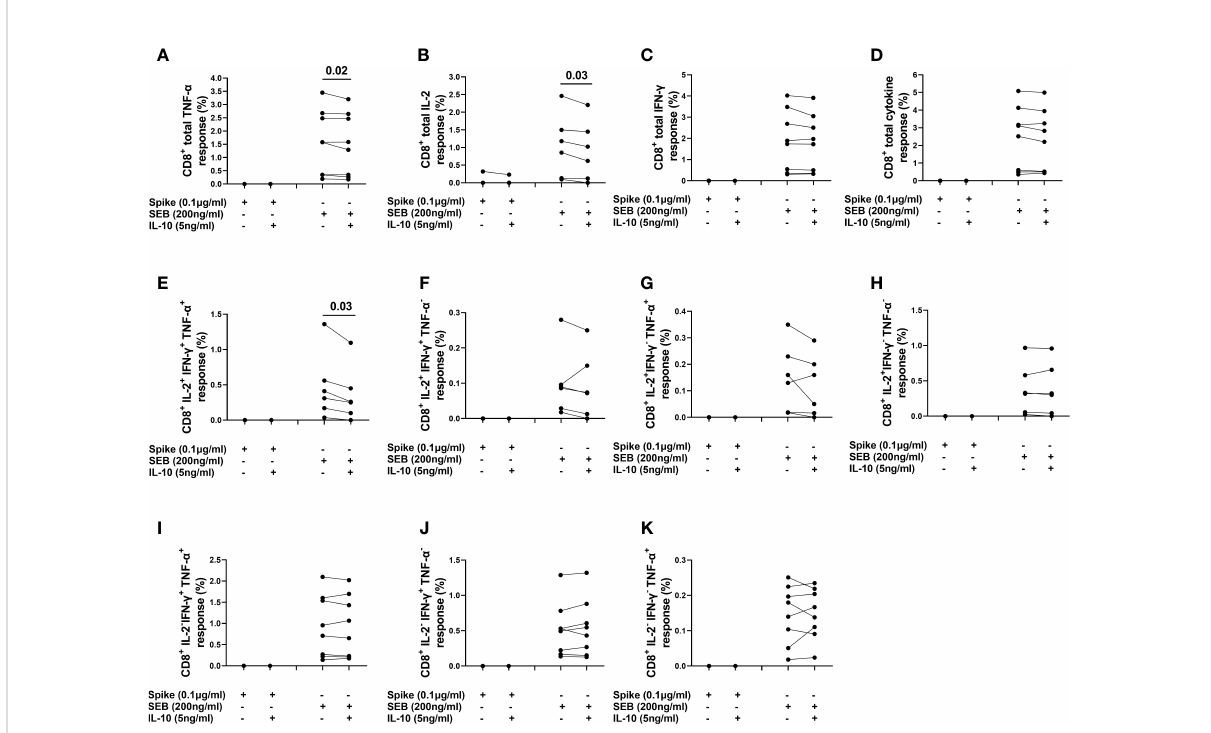
FIGURE 8 Evaluation of the effect of IL-10 on CD8 + T-cells populations in NO COVID-19-Vaccinated Controls of study population “ B ” , by fl ow cytometry (n=8). (A) Percentage of CD8 + TNF- a + cells; (B) percentage of CD8 + IL-2 + cells; (C) percentage of CD8 + IFN- g + cells; (D) percentage of total cytokine response of CD8 + cells; (E) percentage of CD8 + IL-2 + IFN- g + TNF- a + subset; (F) percentage of CD8 + IL-2 + IFN- g + TNF- a - subset; (G) percentage of CD8 + IL-2 + IFN- g - TNF- a + subset; (H) percentage of CD8 + IL-2 + IFN- g - TNF- a - subset; (I) percentage of CD8 + IL-2 + IFN- g + TNF- a - subset CD8 + IL-2 - IFN- g + TNF- a + subset; (J) percentage of CD8 + IL-2 - IFN- g + TNF- a - subset; (K) percentage of CD8 + IL-2 - IFN- g - TNF- a +